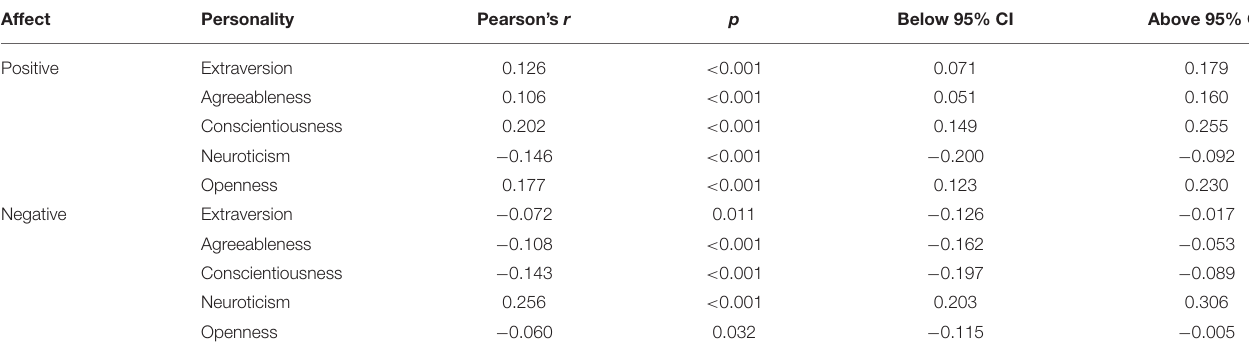
TABLE 1 | Affect and personality—Pearson’s pairwise